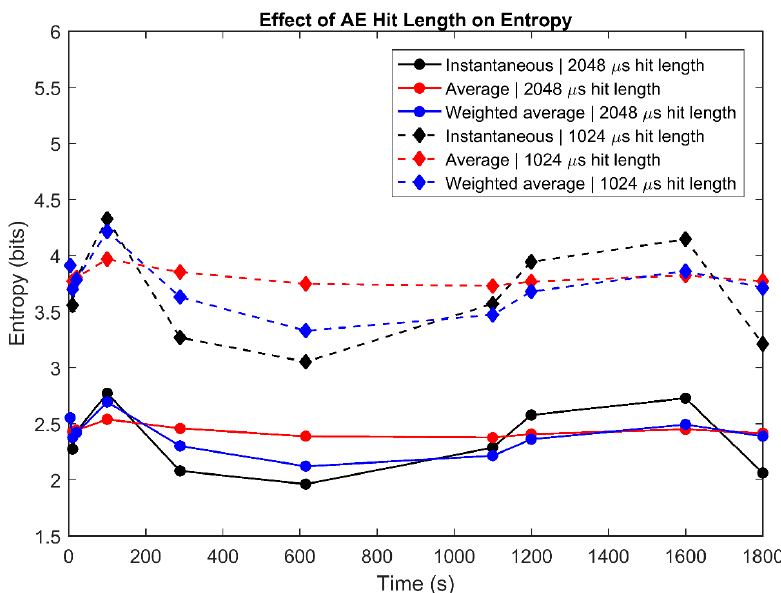
Figure 5. Effect of AE hit length on instantaneous, average, and weighted average entropy showing that the entropy of AE signals with longer hit lengths have lower values than shorter hit lengths while the trends between the entropies are unaffected by the hit length.